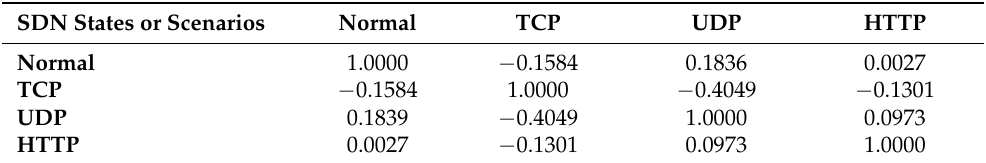
Table 10. Correlation matrix for R t when the SDN is operating normally and subjected to popular variants of DDoS flooding